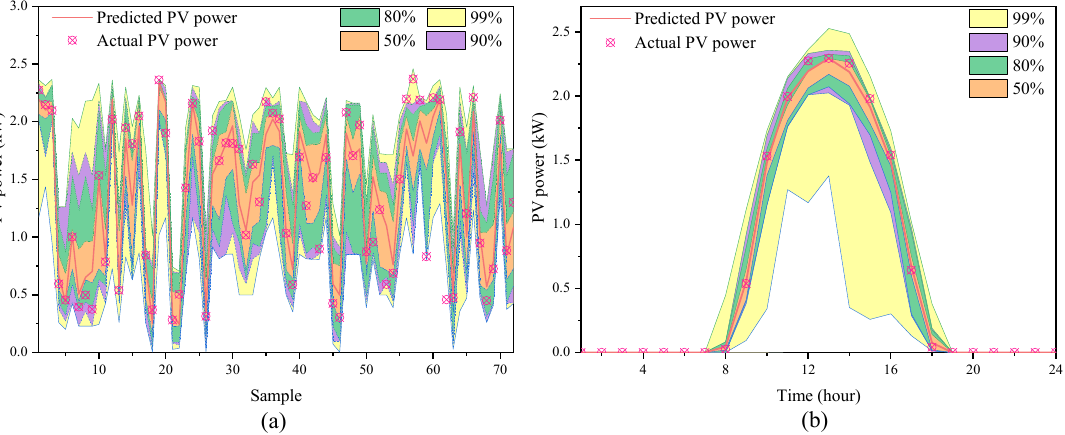
Figure 14. Actual and predicted PV power of various forecasting models for various seasons. ( a ) Probabilistic forecasting results for time period of 11–12 o’clock; ( b ) probabilistic forecasting results of a typical day.